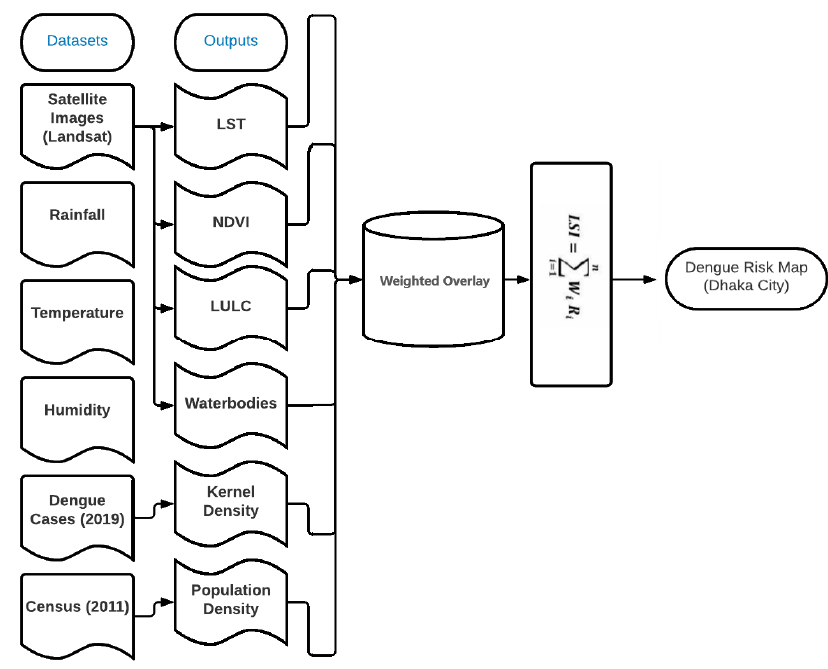
Figure 2. Workflow process involved in this